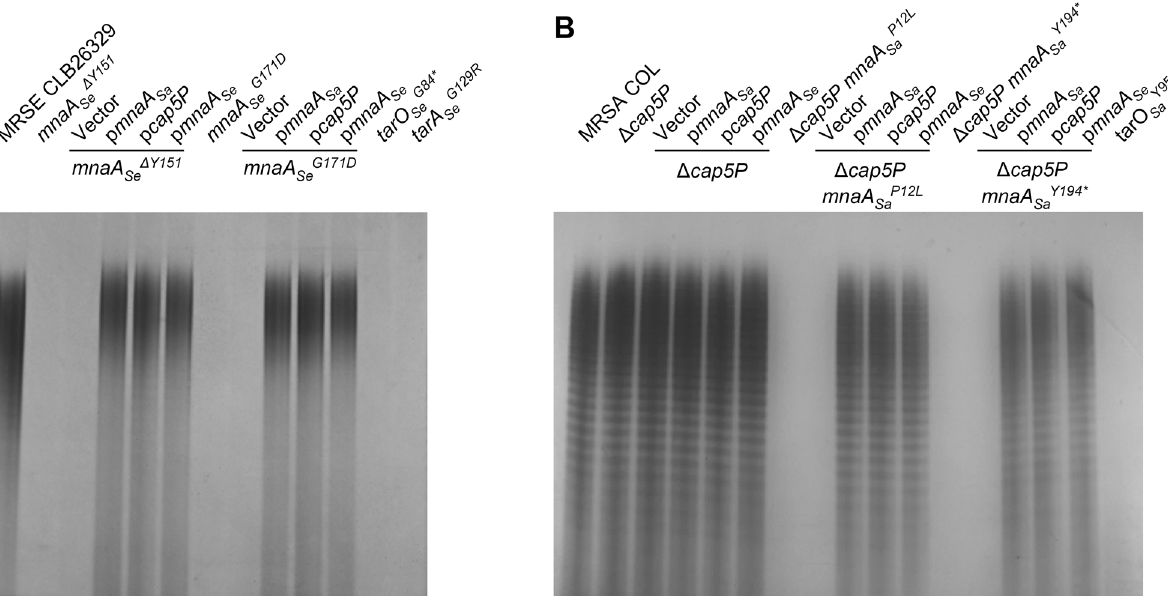
Fig 3. MnaA loss of function mutants in MRSA and MRSE fail to produce WTA. WTA extraction and SDS PAGE analysis from L638 R MRSE CLB26329 (A) and MRSA COL (B) mutants. Note, wild-type MRSA WTA polymers appear as a ladder of discretely sized bands whereas a more diffuse staining of MRSE WTA polymer is observed. WTA material was normalized to cell biomass prior to loading. Wild-type copies of cap5P , mnaA Sa , and mnaA Se , as well as the empty vector introduced into these strains for complementation studies are indicated. The tarO and tarA deletion mutants serve as a control for complete impairment of WTA polymer